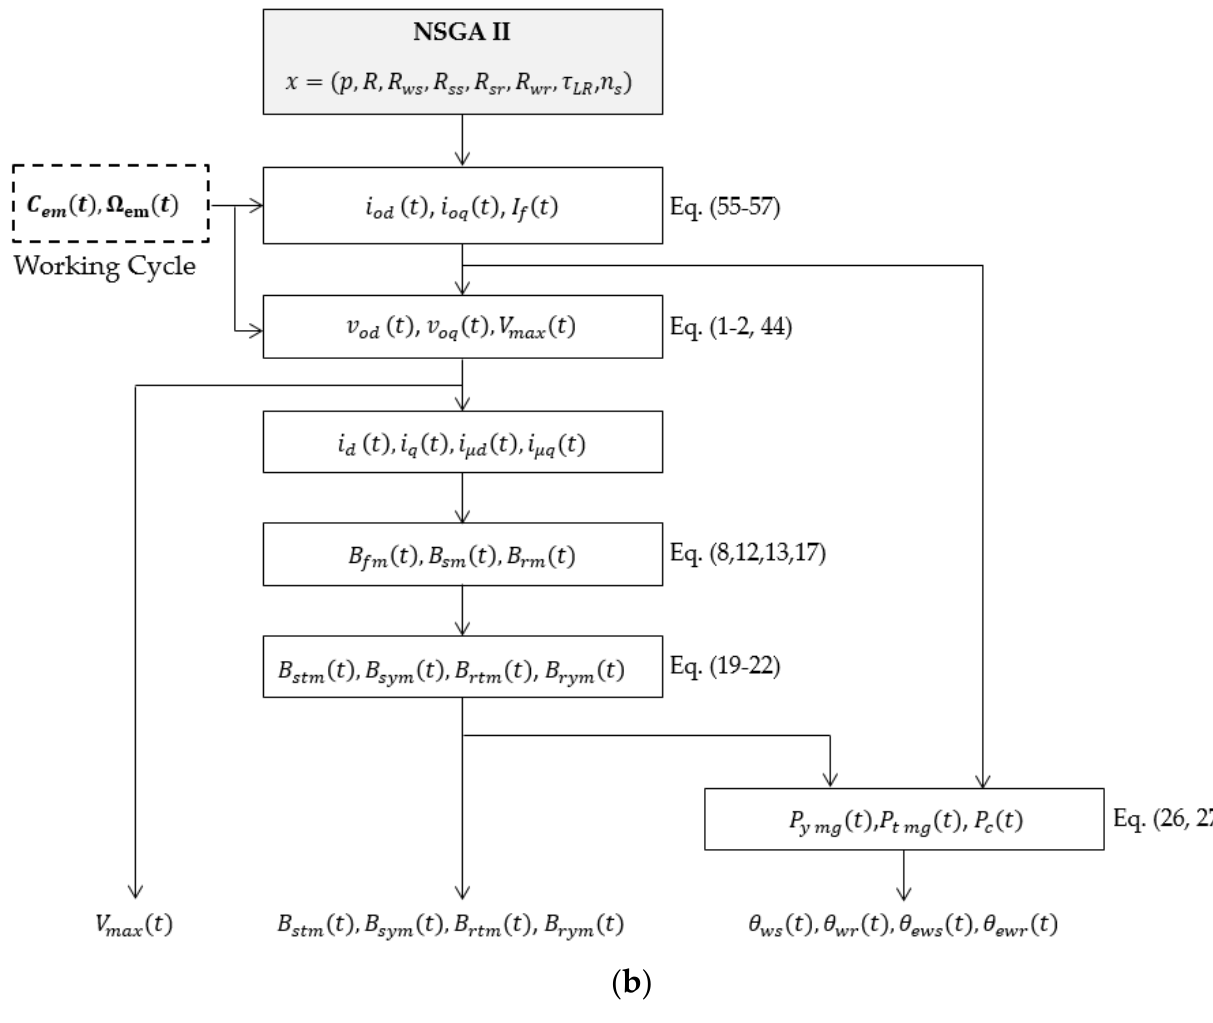
Figure 6. ( a ) General flowchart of the optimization process; ( b ) Flowchart of the analytical calculation.